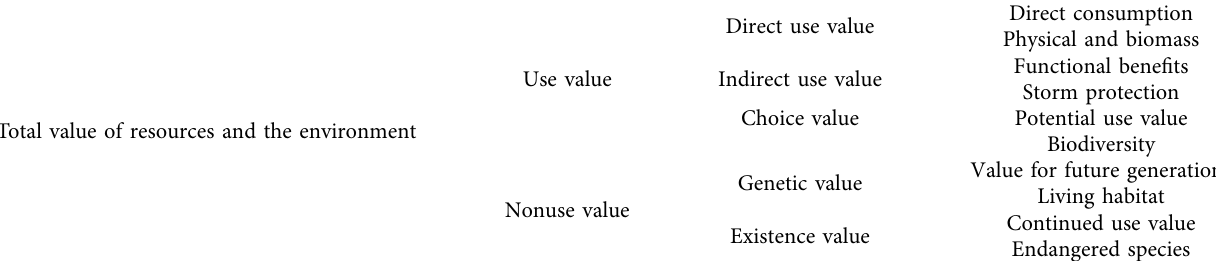
Total value of resources and the